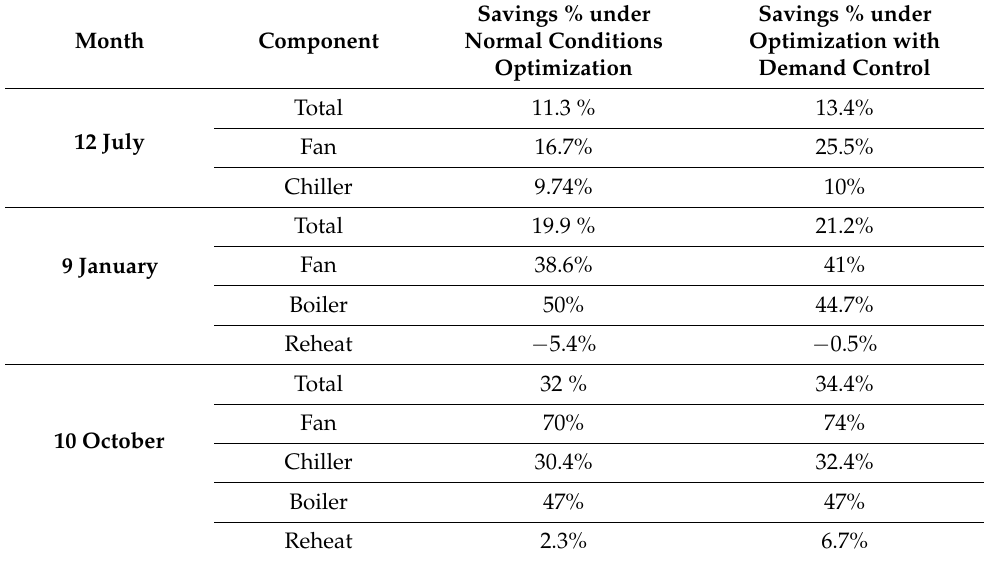
Table 4. The total savings achieved and the percentage of savings for each component.